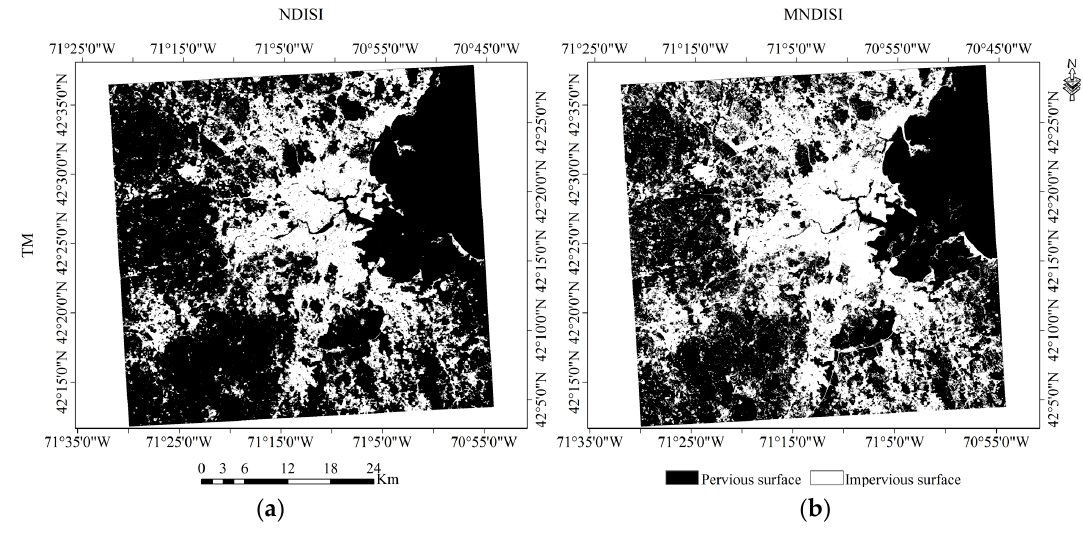
Figure 8. The ISA distributions using: NDISI ( a ); and MNDISI ( b ), from the TM summer images.